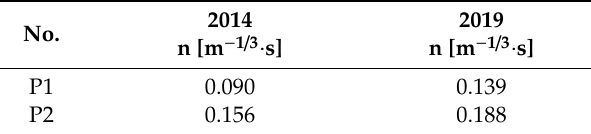
Table 3. Results of calculations of roughness coe ffi